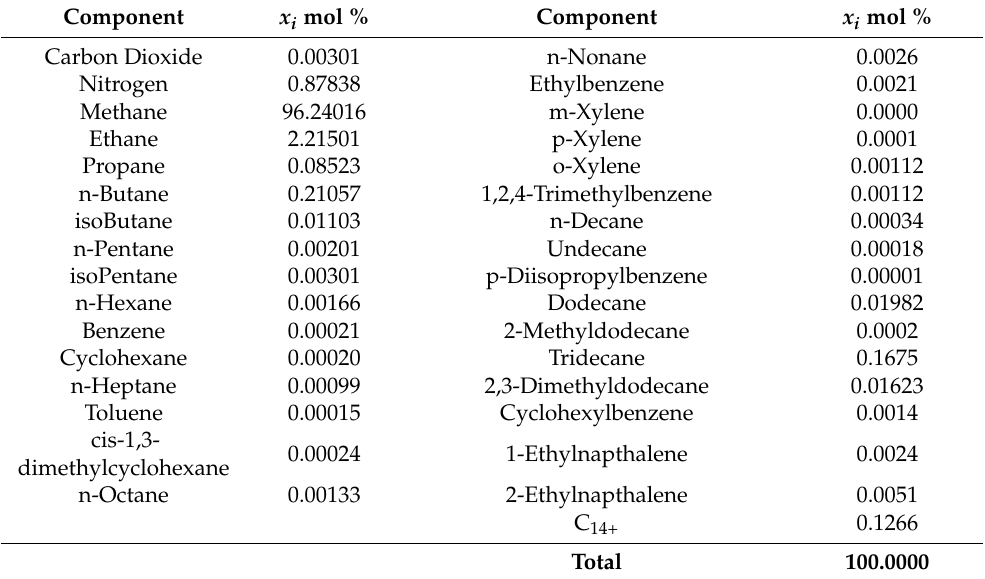
Table 6. Fully characterized composition of Sample 2 (Rich